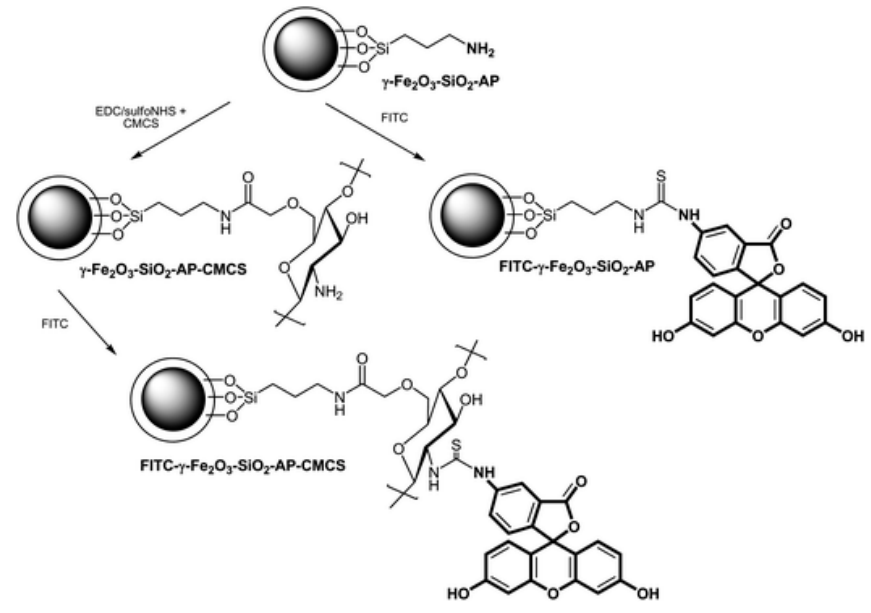
Figure 1. Labelling of γ -Fe 2 O 3 –SiO 2 -AP and γ -Fe 2 O 3 –SiO 2 -AP–CMCS nanoparticles with FITC. Adapted from ref. [19].